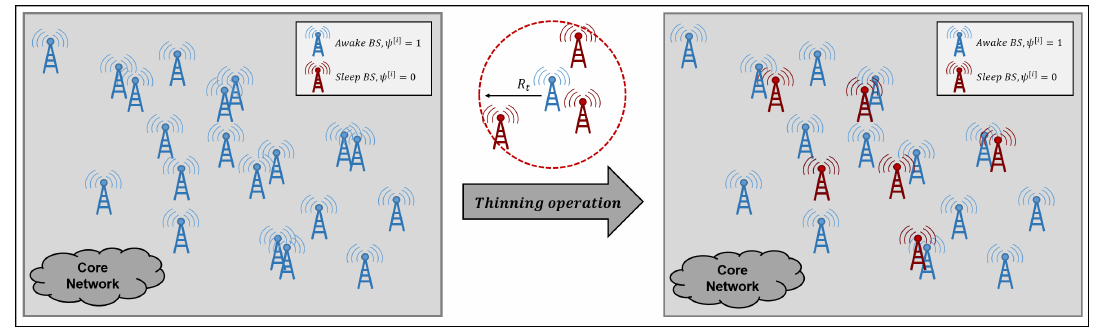
Figure 3. Example of judicious BS control based on approximate thinning